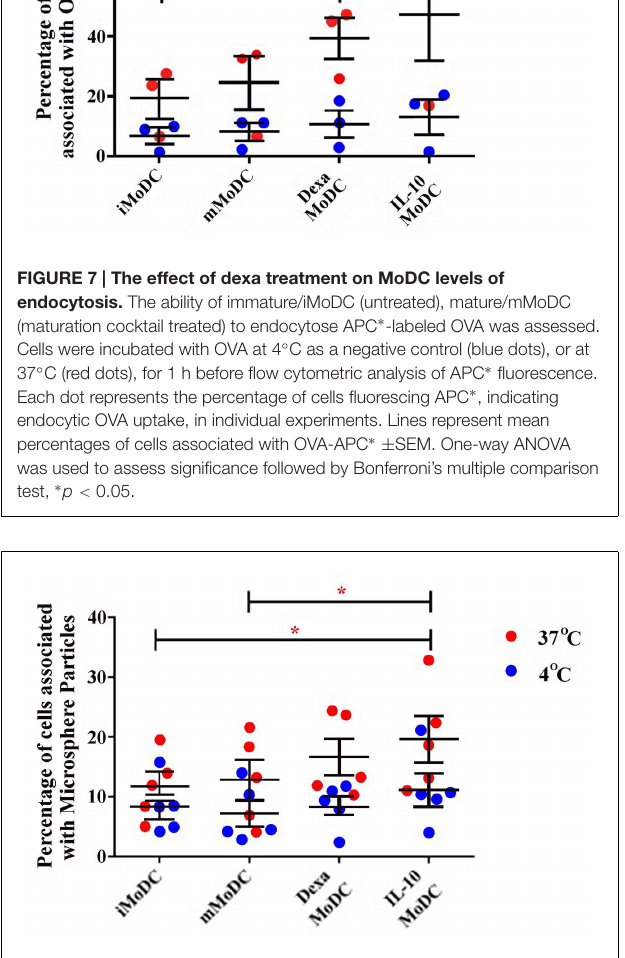
FIGURE 8 | The effect of IL-10 treatment on MoDC levels of phagocytosis. The ability of untreated immature/iMoDC, maturation cocktail treated mature/mMoDC, dexa treated MoDC and IL-10 treated MoDC to phagocytose FITC-labeled microsphere particles was assessed. Cells were incubated with particles at 4 ◦ C as a negative control (blue dots), or at 37 ◦ C (red dots), for 3 h before flow cytometric analysis of FITC fluorescence. Each dot represents the percentage of cells fluorescing FITC, indicating phagocytic uptake, in individual experiments. Lines represent the mean percentage of cells associated with FITC microsphere particles ± SEM. ∗ p < 0.05